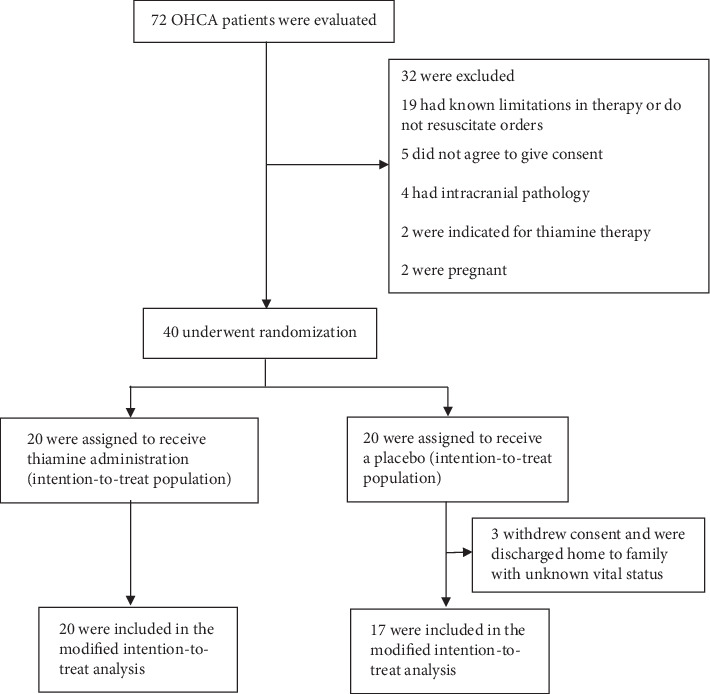
Flow diagram describing the screening, recruitment, and randomization of patients. OHCA, out-of-hospital cardiac arrest.